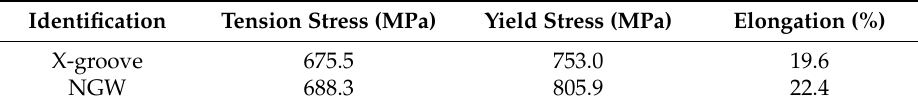
Table 4. Comparison of tensile test results.